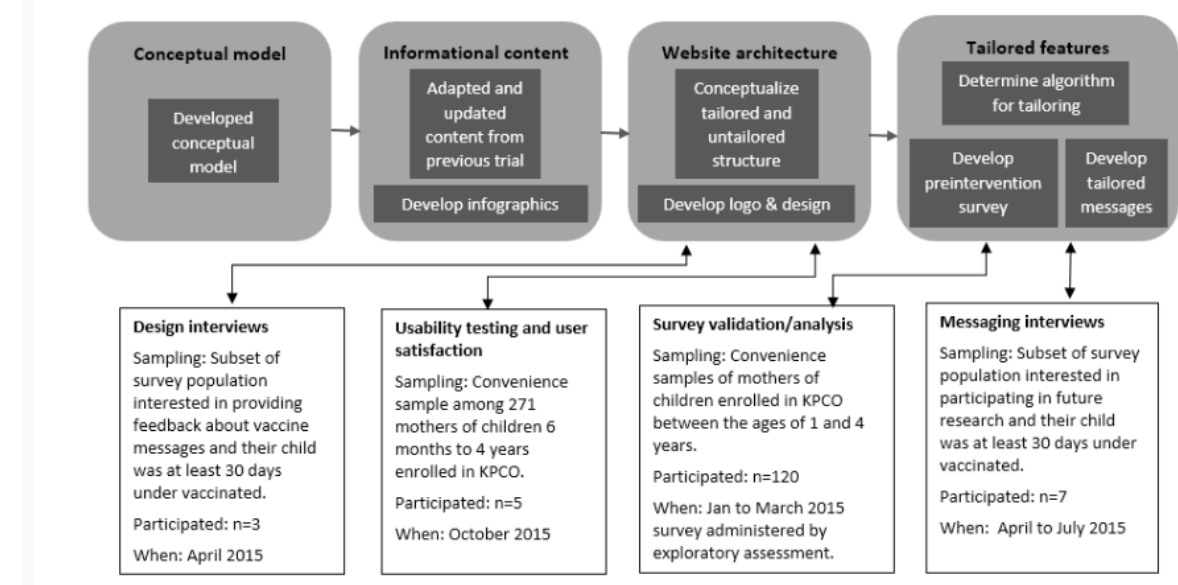
Figure 2. Study participant flow and